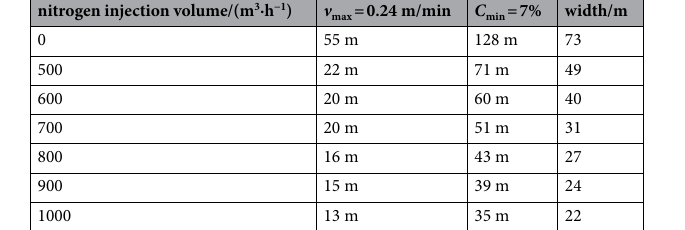
nitrogen injection volume/(m 3 ∙h −1